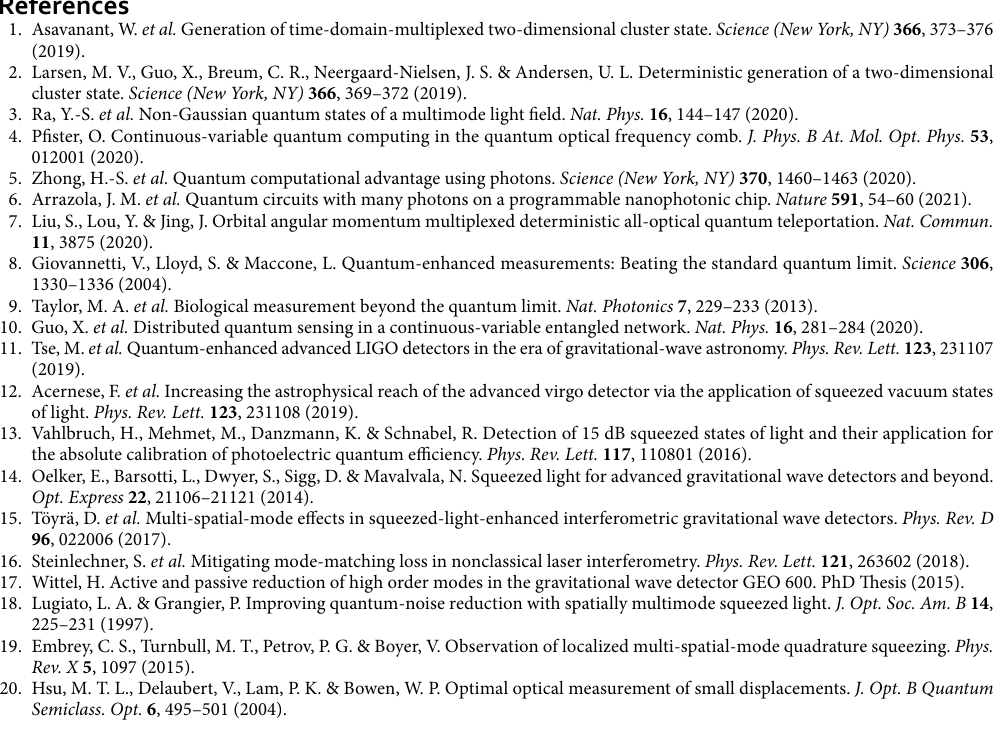
ω π/ 25 , and 0.1 , T l 1 / 2 0 , g 00 = ˜ = ˜ = =